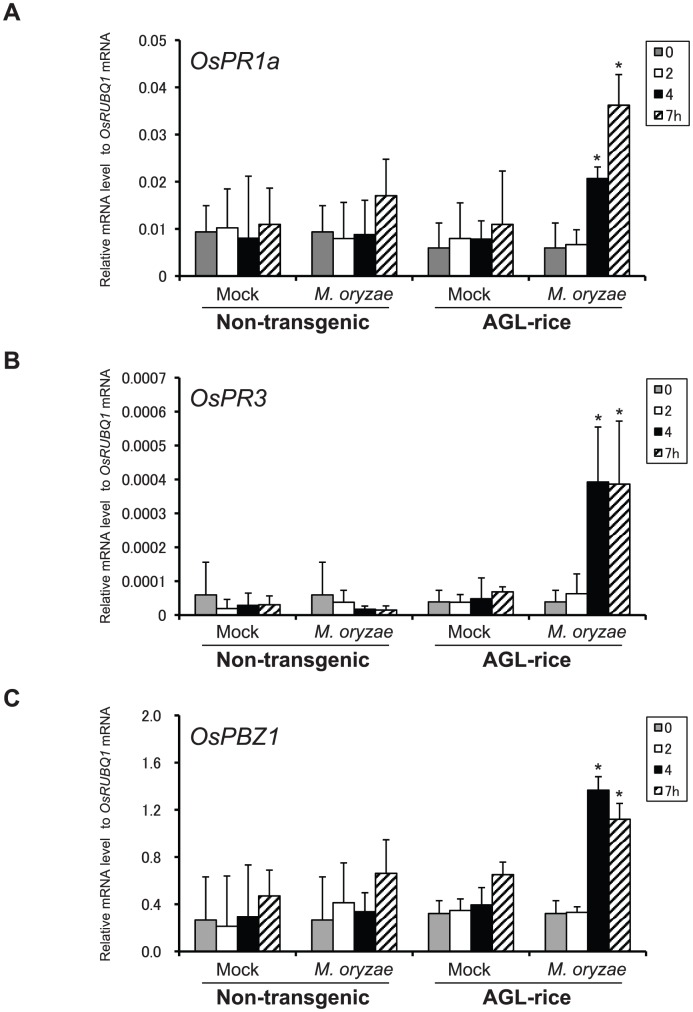
The expression of representative PR genes in AGL-expressing rice (AGL-rice) inoculated with M. oryzae.The expression of (A) OsPR1a, (B) OsPR3 and (C) PBZ1 relative to the OsRUBQ1 gene. Rice plants were sprayed with a wild-type M. oryzae (Ina86-137) conidial suspension or distilled water (mock). The gene expression was analyzed using qRT-PCR at 0, 2, 4, and 7 hpi. The results represent the mean ± SD from at least three independent experiments. The significant differences against the control (mock) at the same time point in each series of tests are indicated by asterisks (Dunnett's test, P<0.05).